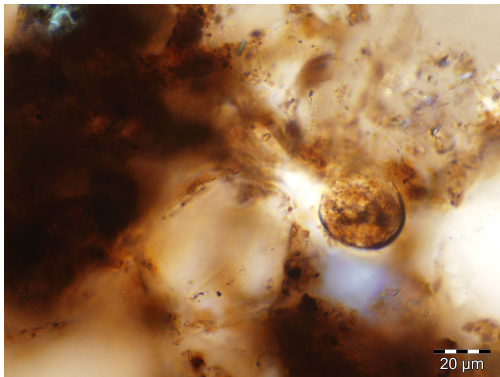
Figure 5. Pollen grains, visible in a welded aggregate of the same thin sections. Pollen grains in thin sections are observable as opaque, empty spheroidal objects. The palynological characteristics as sculpture and aperture are not visible without the chemical treat- ments during pollen